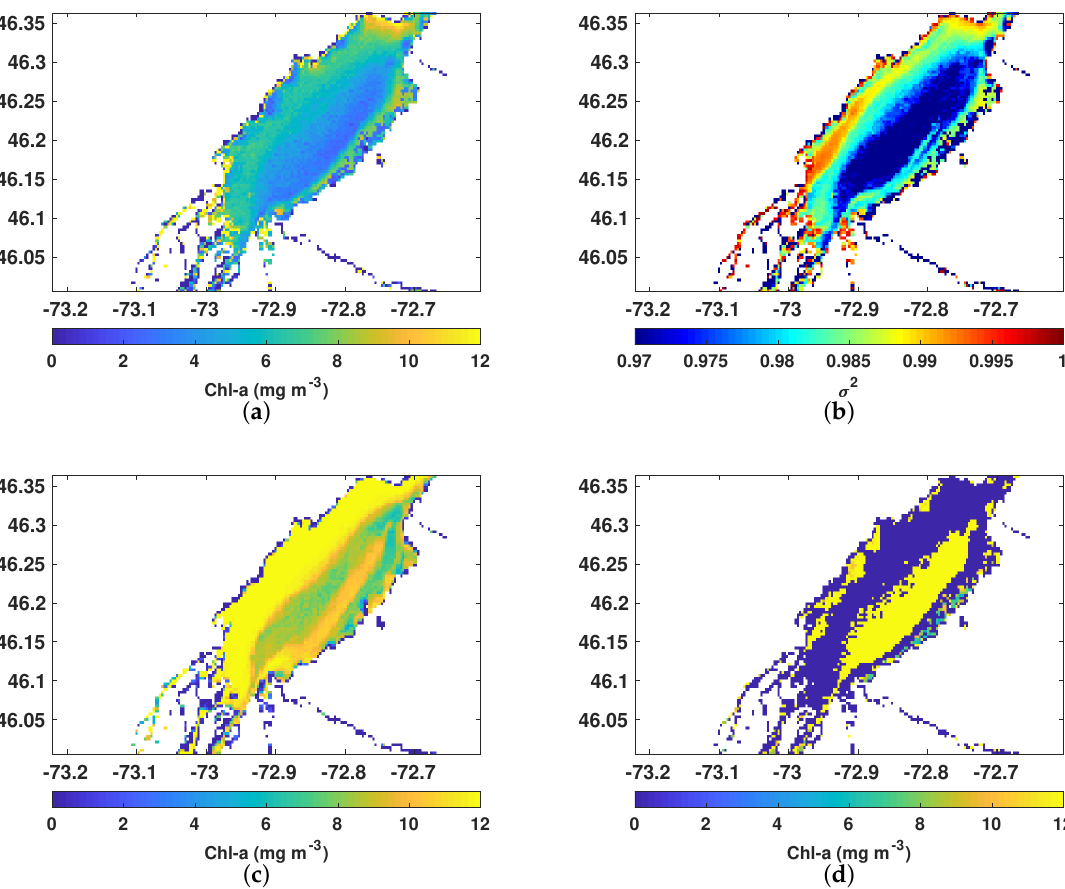
Figure 13. Region 4, Lac Saint-Pierre: Estimated Chl-a concentration ( a ) and the corresponding certainty map ( b ). Chl-a concentration map by the NNs ( c ) and OC4 ( d ). The unit of Chl-a is mg m − 3 , and the certainty (variance) is